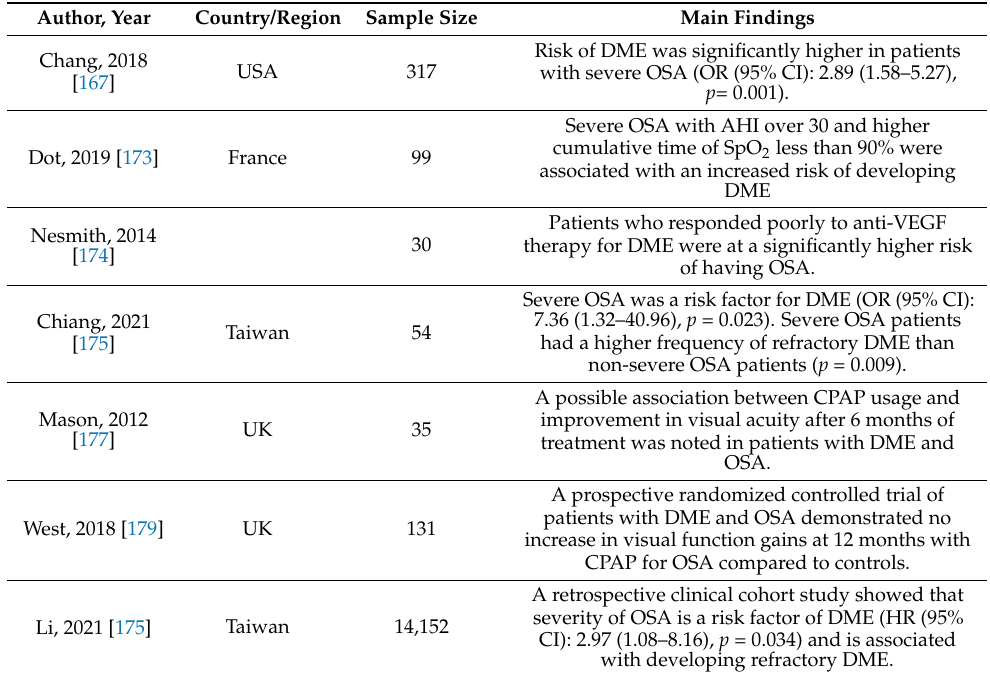
Table A7. Summary of the major studies evaluating the association between OSA and